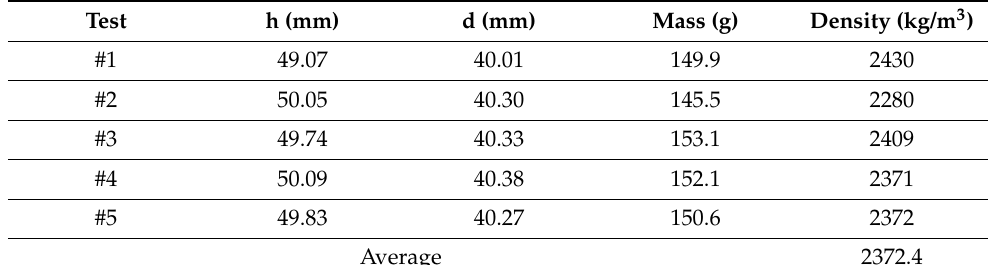
Table 3. Initial dimensions and calculated density of the samples tested in quasioedometric